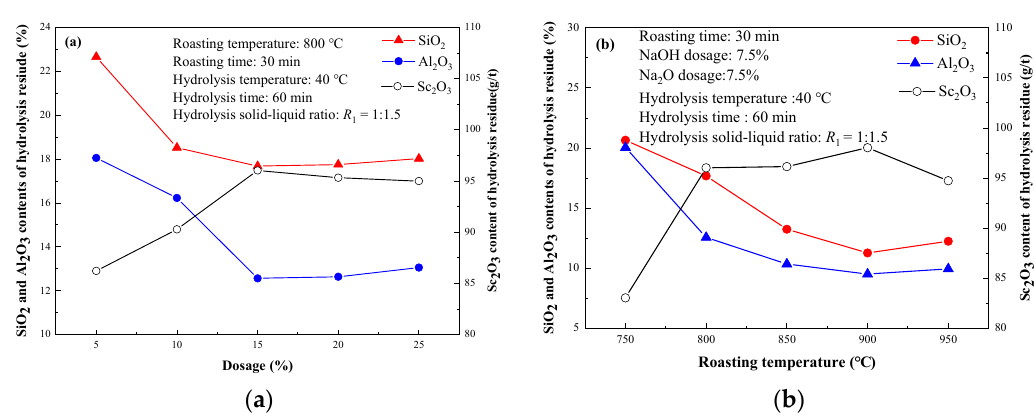
Figure 3. Effect results of fusion agent dosage ( a ) and alkali fusion roasting temperature ( b ).